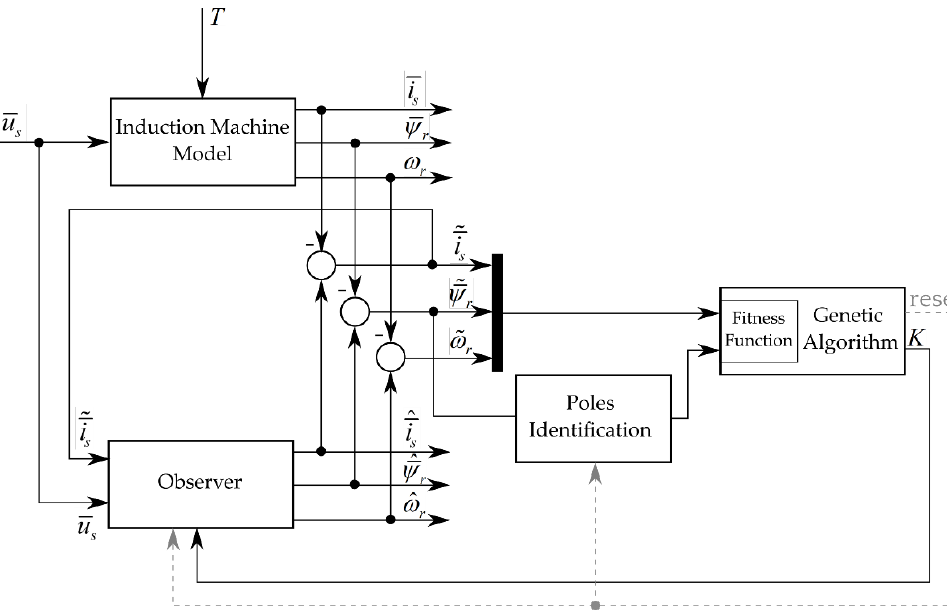
Figure 2. Block diagram of gains selection system.